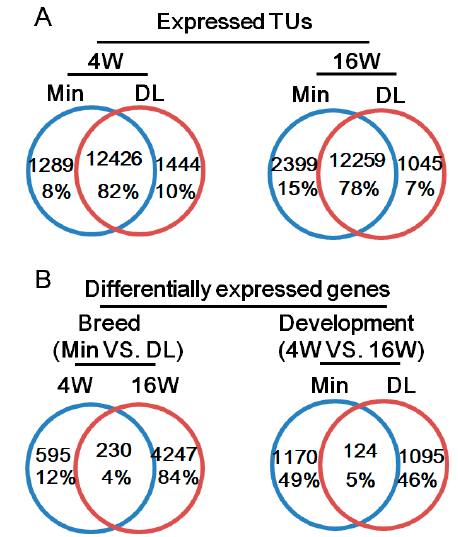
Figure 2. Gene identification and differentially expressed genes (DEGs) in DL and Min pigs. ( A ) The expressed transcription units in each pig breed. Transcription units with normalized read count were considered “expressed transcription units.” 4 W, 4-week-old pigs; 16 W, 16-week-old pigs. ( B ) DEGs in each pig breed (Fragments Per Kilobase of exon per Million fragments mapped (FPKM) fold-change > 2; p < 0.05).